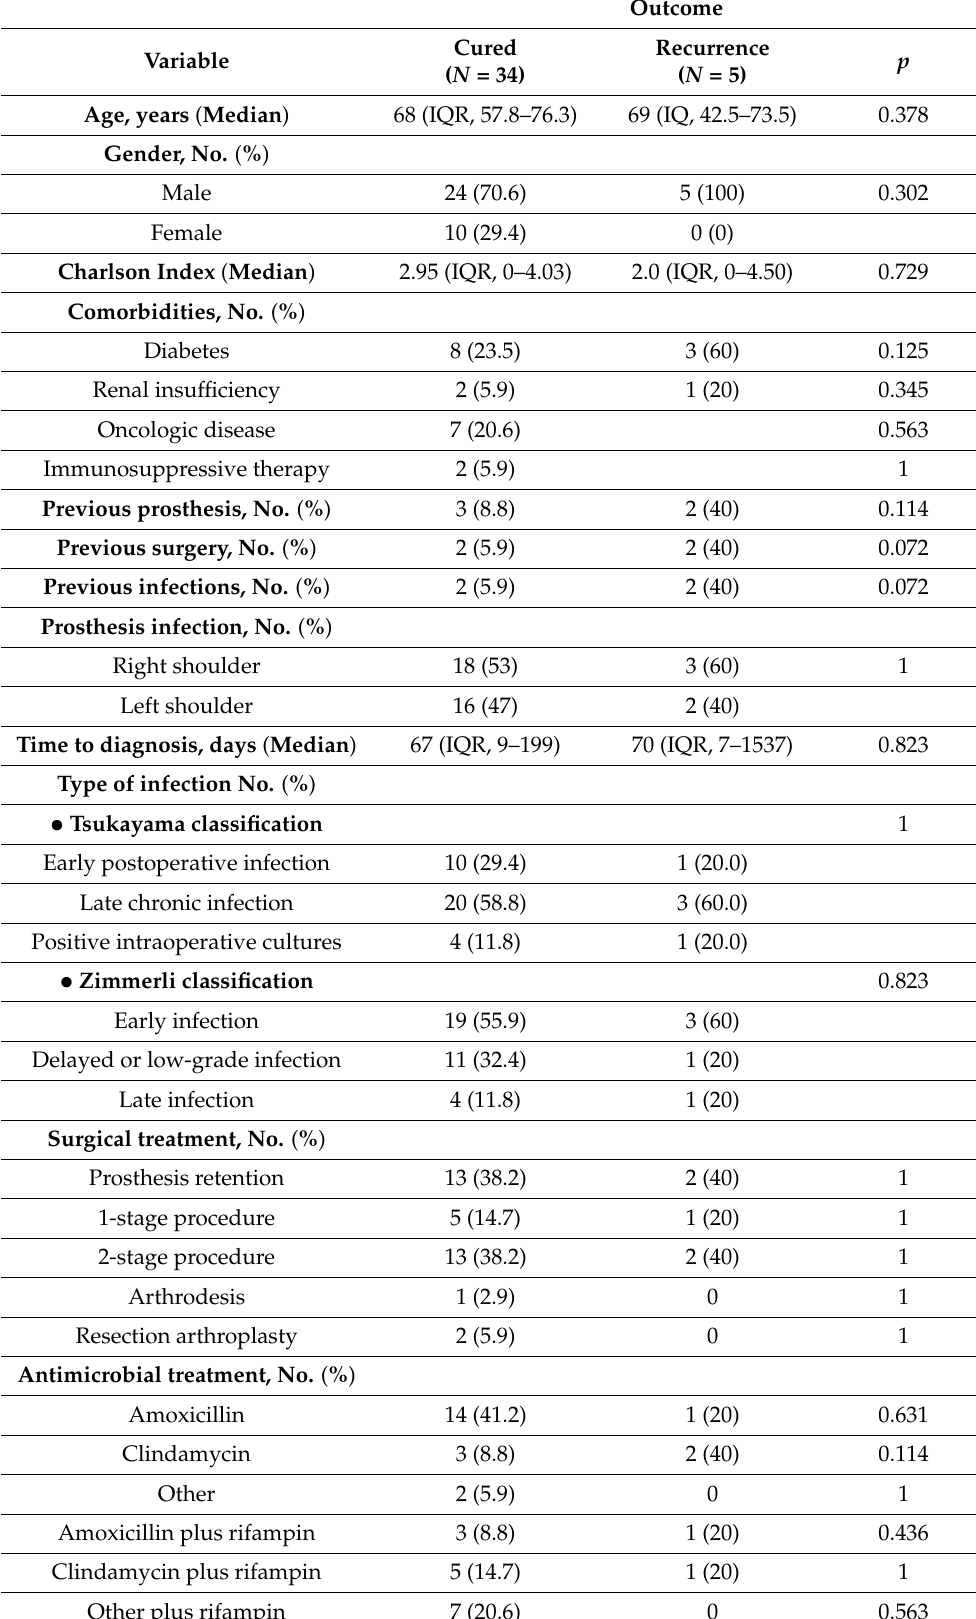
Table 4. Comparison of final